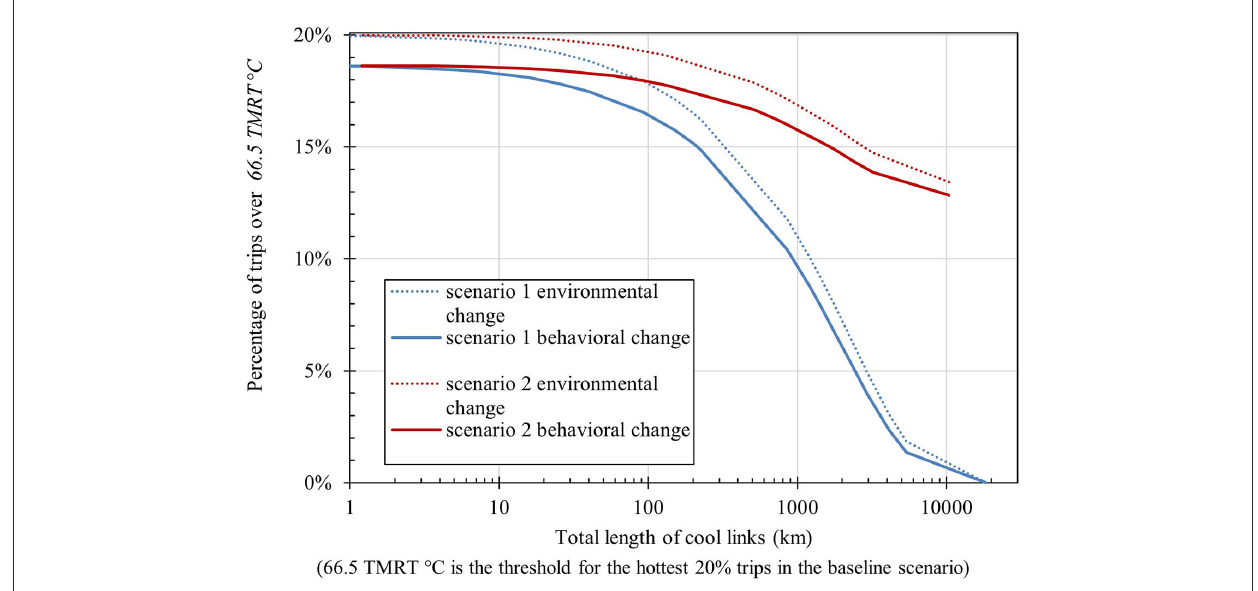
FIGURE7 Cooling of the hottest 20% trips. Hottest trips are defined as heat exposure over 66.5 ◦ C. The y-axis represents the percentage of trips that have their heat exposure over 66.5 ◦ C. The blue lines represent the street’s cooling condition in scenario 1 where the roadways’ temperature is reduced to the lowest 10%. The red lines represent the street’s cooling condition in scenario 2 where the roadways’ temperature is reduced to the lowest